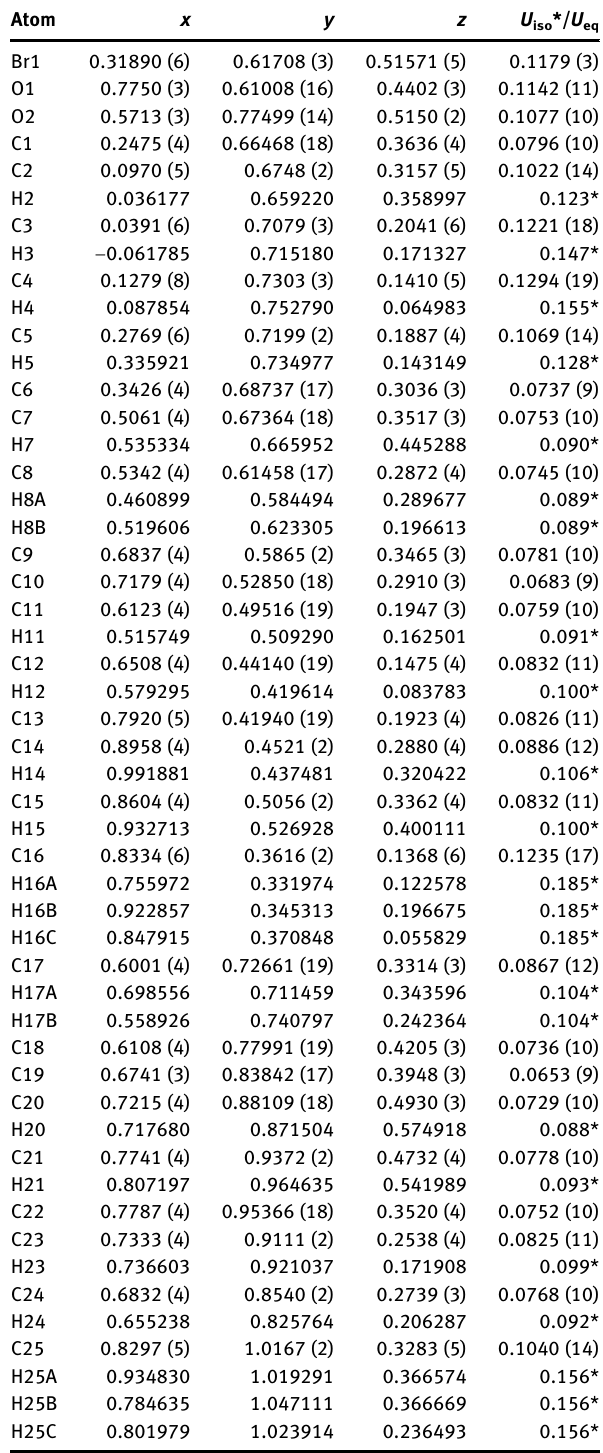
Table  : Fractional atomic coordinates and isotropic or equivalent isotropic displacement parameters (Å 